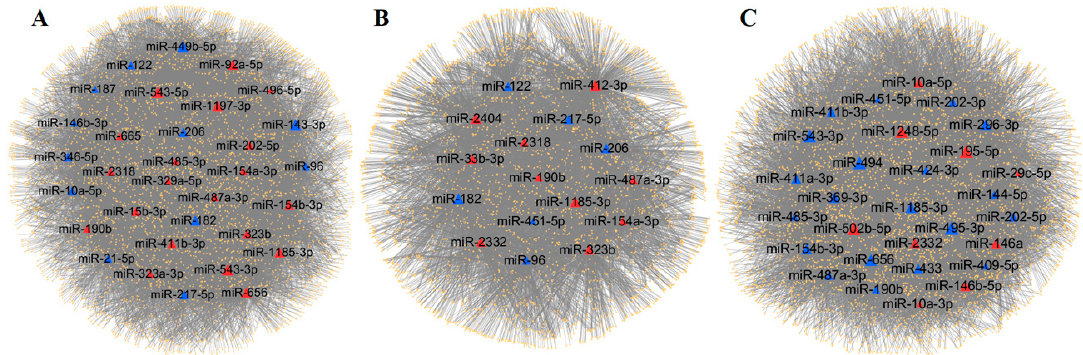
Figure 4. Target genes of the DEmiRNAs. ( A ) Interaction network of the DEmiRNAs–target genes in OS vs. LF, ( B ) in OS vs. SF, and ( C ) in LF vs. SF.